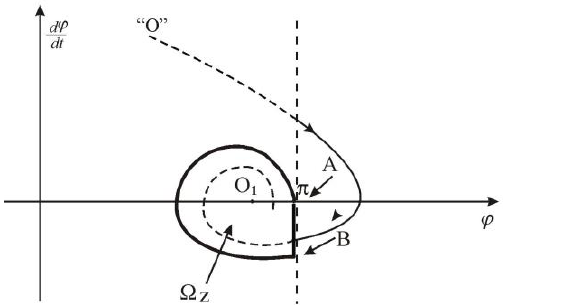
Fig. 3. Phase portraits in the PLL with additional process control for the case when the instantaneous frequency detuning is not very large.